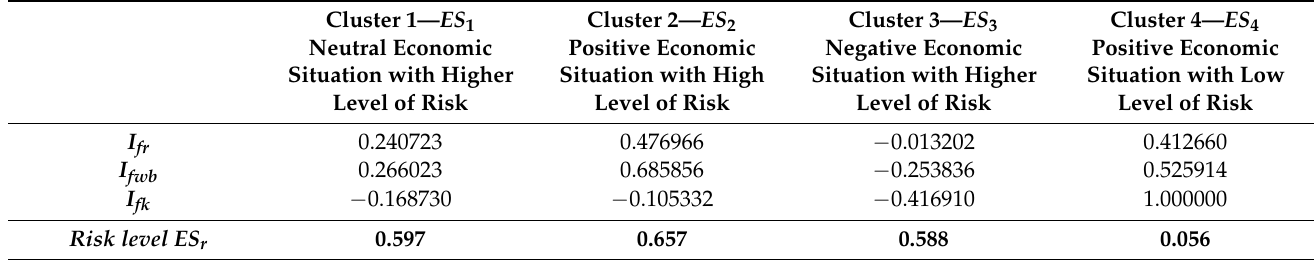
Table 2. Means for each economic situation cluster.